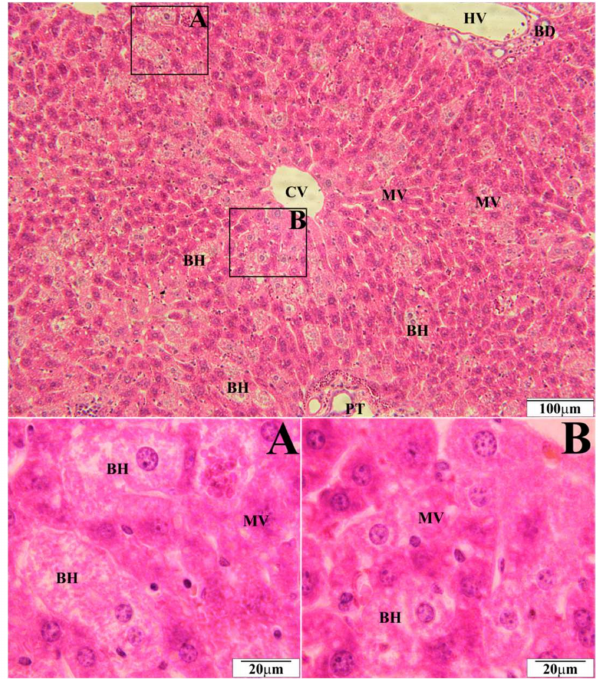
Figure 1. Representative section of the liver of C 57 BL 6 mice on a high-fat diet (HFD). Slides stained with Hematoxylin and Eosin. BD—bile duct, BH—ballooned hepatocytes, CV—central vein, HV—hepatic portal vein, MV—microvesicular fatty hepatocytes, PT—portal triad.